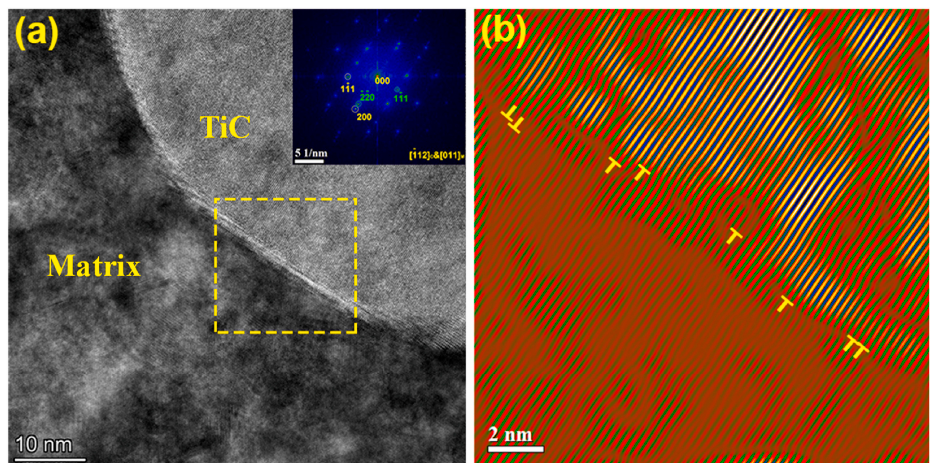
Figure 14. Interfacial bonding of TiC particles and GTD222 matrix [5]. Figure 14. ( a ) Interfacial bonding of TiC particles and GTD222 matrix, ( b ) Dislocations (yellow symbols)